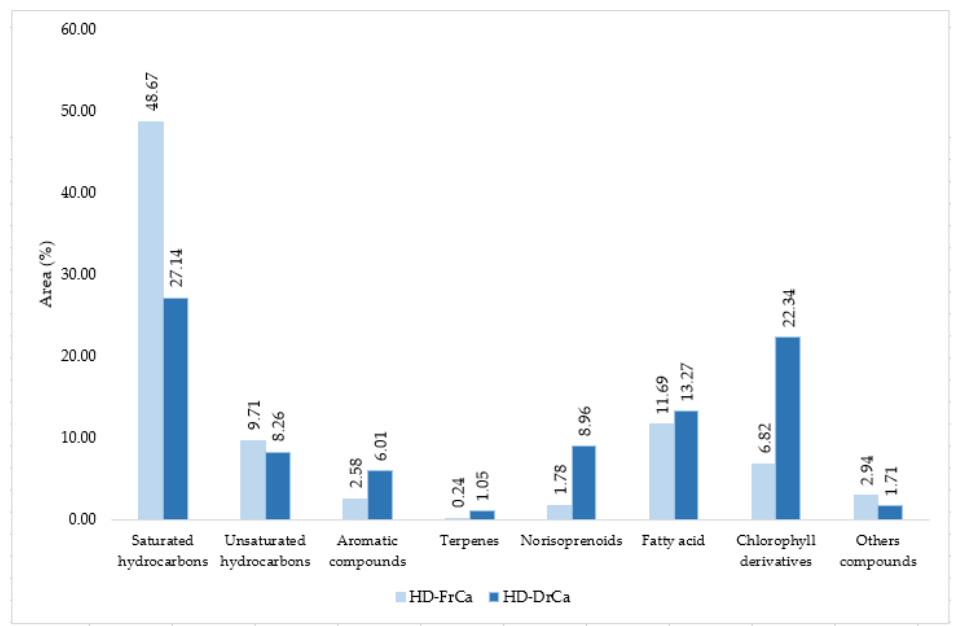
Figure 2. The VOCs from C. adhaerens obtained by HD sorted by structural groups.